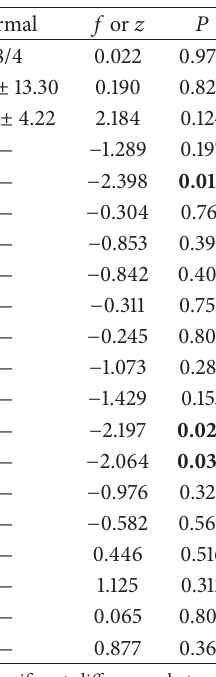
patient, along with their follow-up CT and/or MRI